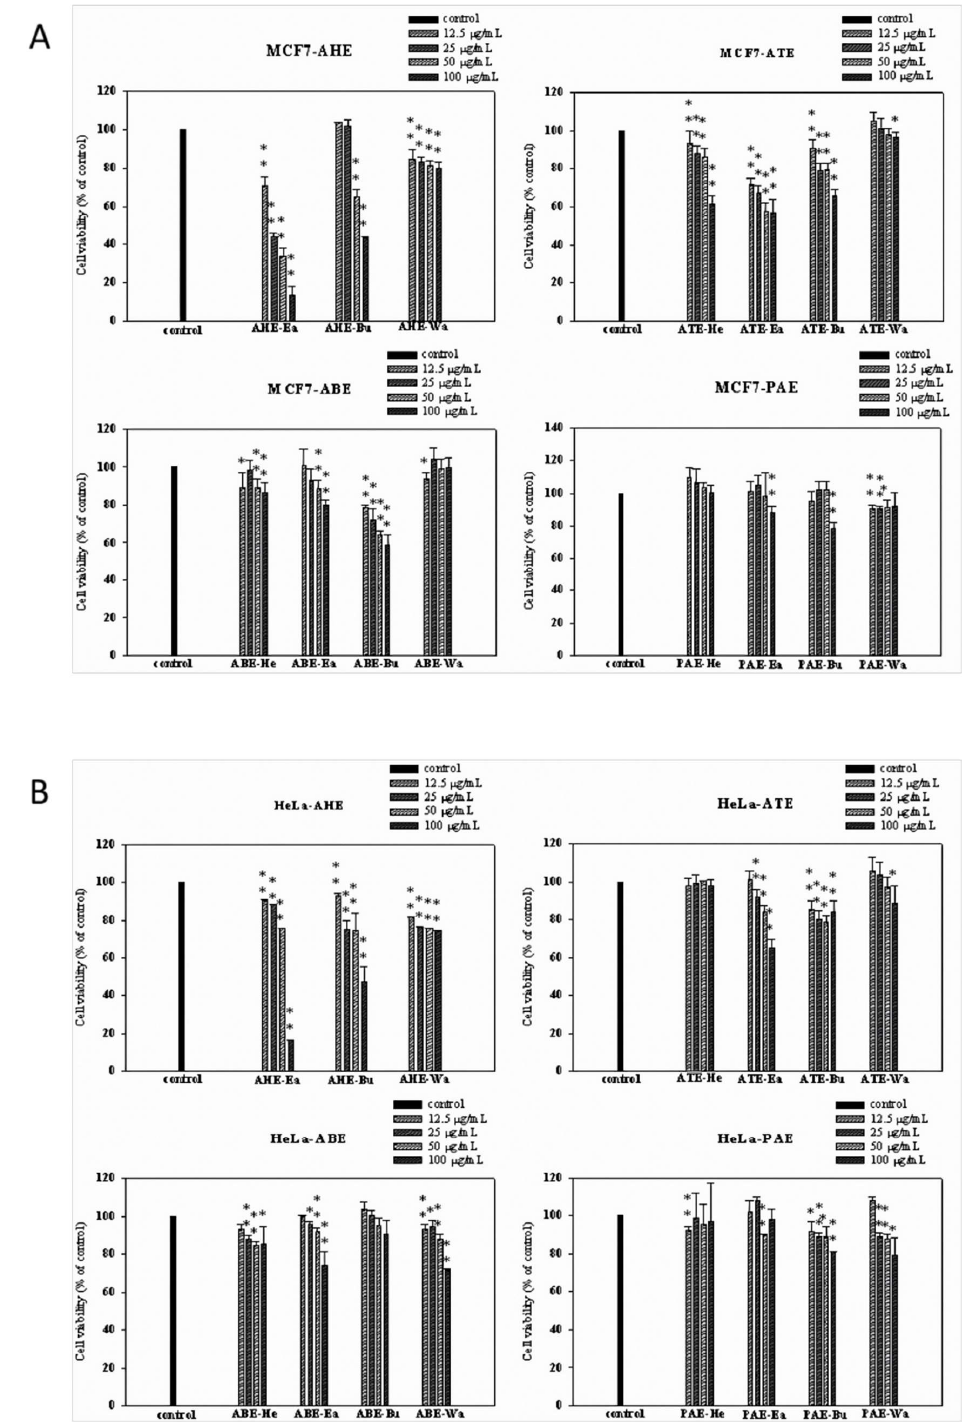
Figure 1. The antiproliferative effects of different fractions from various adlay seed ethanolic extracts on ( A ) MCF-7 and ( B ) HeLa cells. The MCF-7 and HeLa cells (2 × 10 3 cells/well) were cultured with or without treatment (0, 12.5, 25, 50 and 100 μg/mL) for 72 h and cell viability was measured using an MTT assay. The results were expressed as a percentage of living cells cultured in the presence of treatment compared to the untreated control. Each bar represents the mean ± SD ( n = 3). The statistical significance was measured using Student’s t-tests: * p < 0.05 compared to the control group; ** p < 0.01 compared to the control group (con, control; He, hexane; Bu, butanol; Wa,